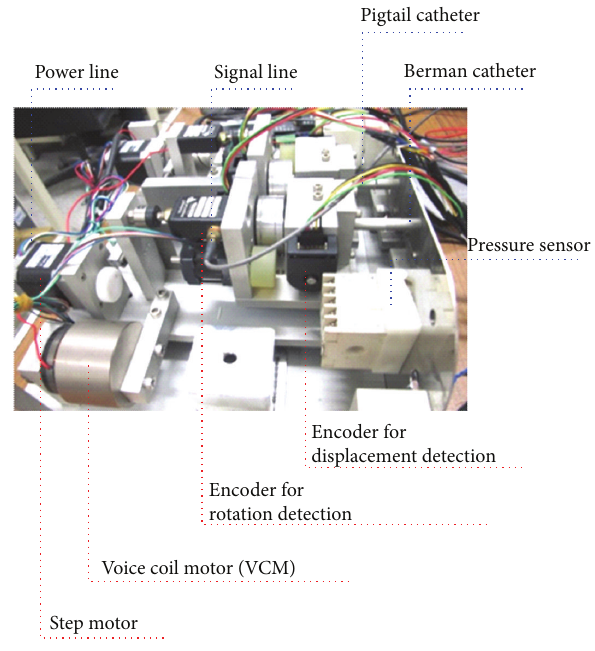
Figure 8: The double-catheter mechanism for ICC.